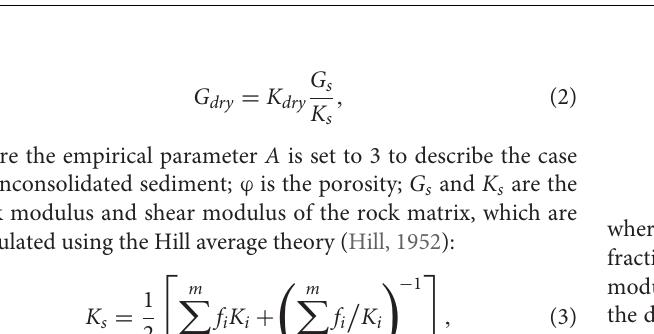
FIGURE 3 | (A) P-wave velocity Vp and (B) attenuation factor 1/Qp vary with gas hydrate saturation and